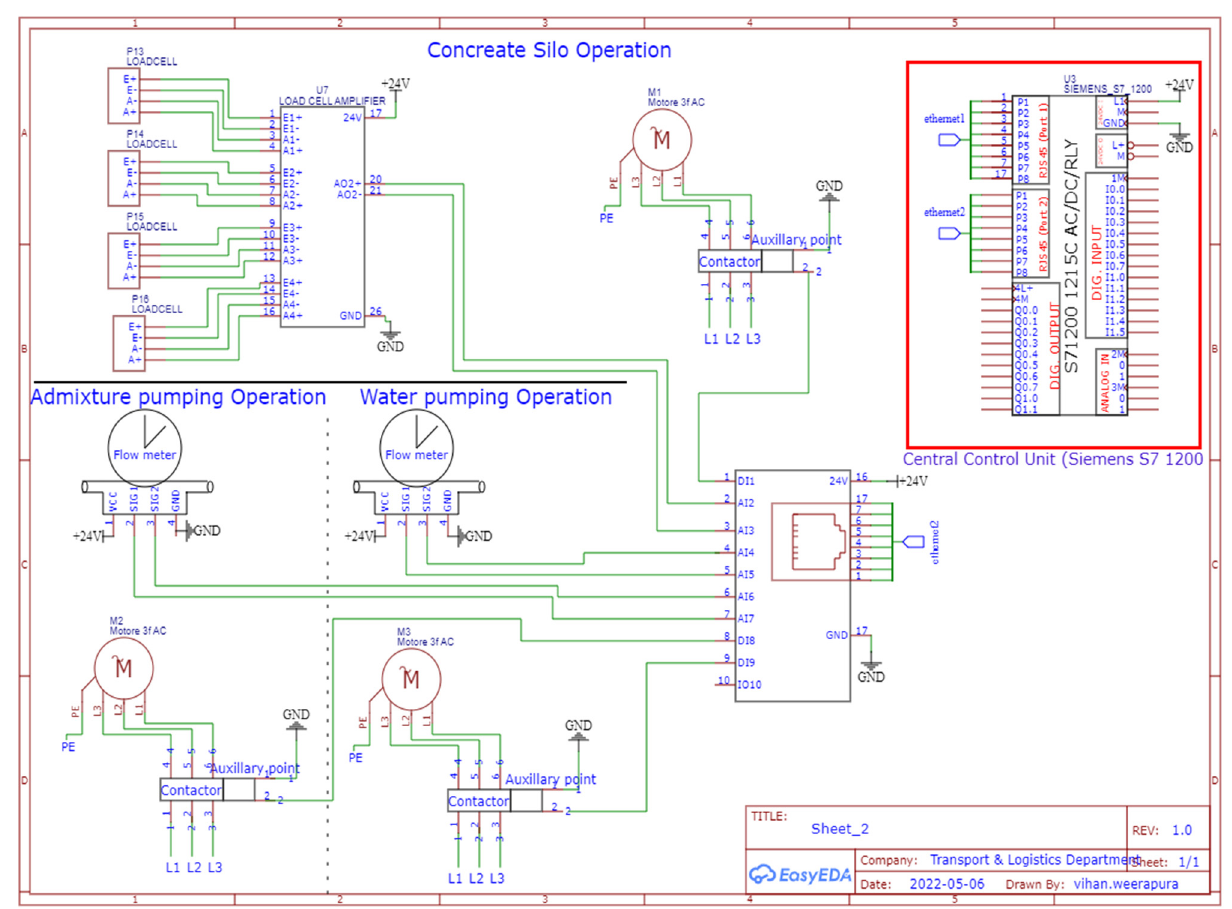
Figure 14. IoT Electrical Schematic Diagram Part 2.